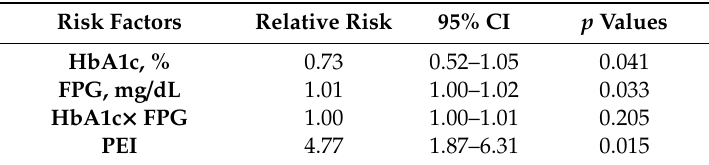
Table 5. A proportional hazards analysis of risk factors for incidence of DPN within six years of follow-up in diabetic patients. Risk Factors Relative Risk 95% CI p Values HbA1c,